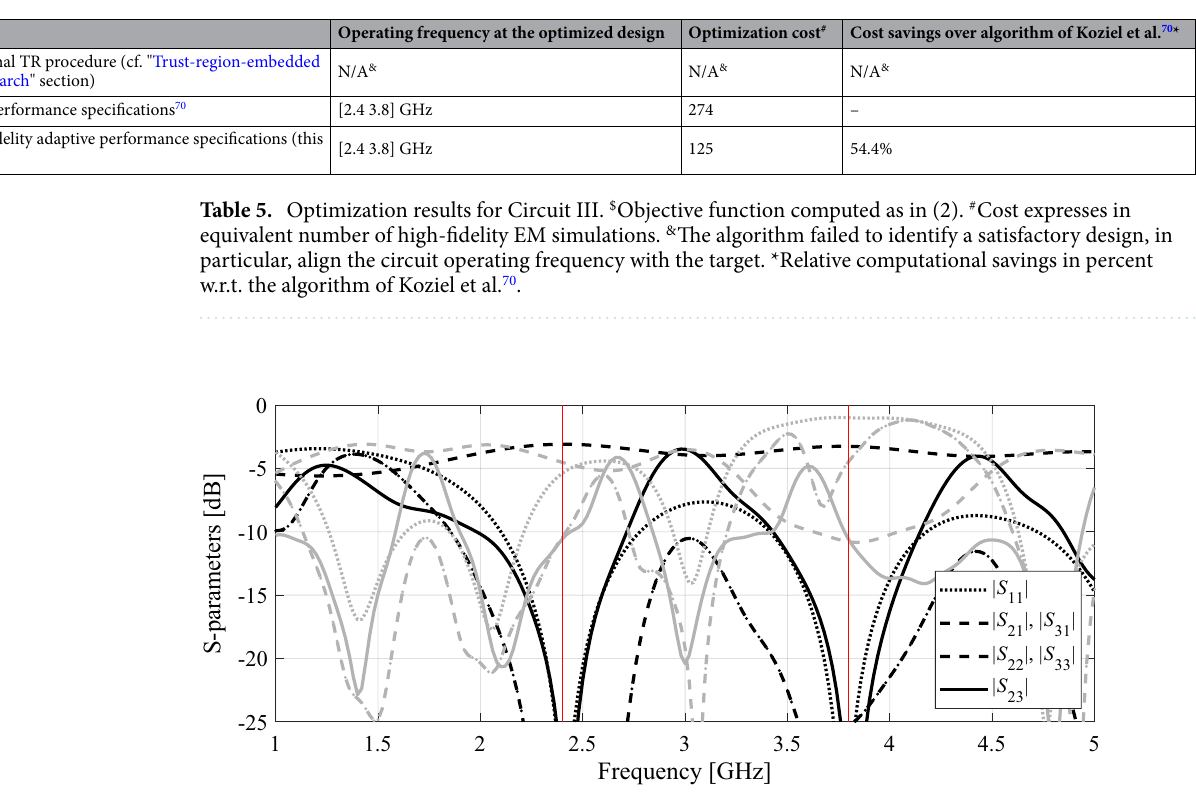
Figure 13. Dual-band power divider: circuit responses at the initial design (grey lines), and the optimal design rendered by the introduced framework with design specification adaptation and variable-fidelity models (black lines). Vertical lines mark target operating frequencies.